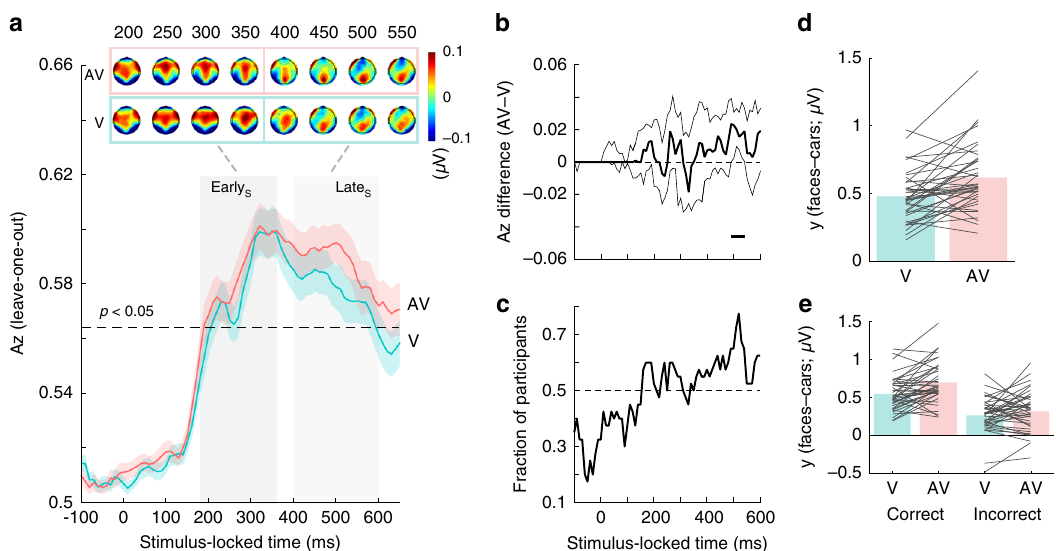
Fig. 3 Stimulus-locked face-vs-car discrimination analysis. a Mean discriminator performance ( A z ) during face-vs-car discrimination of stimulus-locked EEG data after a leave-one-trial-out cross-validation procedure, as a function of the visual (V; turquoise) and audiovisual (AV; red) conditions. Dashed black line represents the group average permutation threshold at p < 0.05. Shaded error bars indicate bootstrapped standard errors (SEM) across participants. Shaded gray vertical bars indicate Early and Late EEG component windows determined using temporal clustering of scalp topographies. The number of clusters and their extent was obtained via a k -means clustering algorithm that used a Euclidean distance metric and optimized k (for details, see “ Methods ” ). These bars do not indicate statistical signi fi cance. Scalp topographies at representative time windows corresponding to the Early and Late EEG components, encoding sensory and post-sensory visual evidence, respectively. Colourbar represents normalized amplitude ( µ V). b Bootstrapped difference in discriminator performance (AV – V; thick black line) with 95% con fi dence intervals (2.5 – 97.5%; thin black lines). Horizontal thick black line above the x - axis in b illustrates signi fi cant temporal windows resulting from this one-sided permutation test (i.e., those in which the lower con fi dence interval is greater than zero ( p < 0.025) with an added data-driven minimum requirement of three contiguous windows to correct for multiple comparisons; see “ Methods ” ). c Fraction of participants showing discriminator performance ( A z ) in the same direction as the group-level mean. d Late EEG component amplitudes re fl ecting the relative separation across all face and car trials ( y faces – y cars ) at the point of maximum A z separation between V and AV trials (see a , b ). e Late EEG component amplitudes ( y ) as in d separated by decision accuracy. Reproducibility was ensured using an out of sample leave-one-trial-out cross- validation procedure per participant, thereby each participant becomes its own replication unit (for details, see “ Methods ” ). Source data for this fi gure are provided as a Source data fi